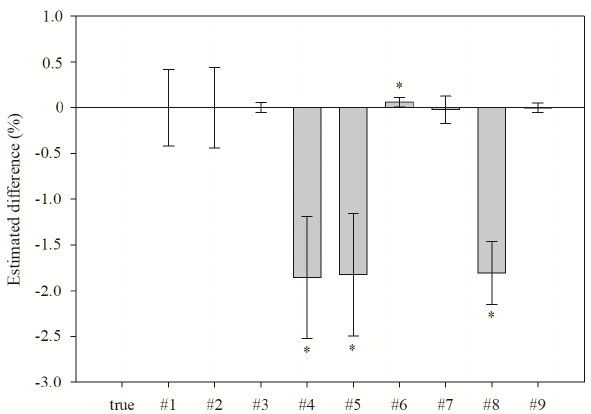
Figure 1. Statistical analysis of the deviation of the estimated area from the observed area for an individual leaf. Leaf area for Eugenia uniflora was estimated using several models in which β and β are coefficients. Vertical 0 1 bars denote means and spreads denote 99% confidence intervals of the difference. Numbers below the graph denote model numbers (see further details in the Table